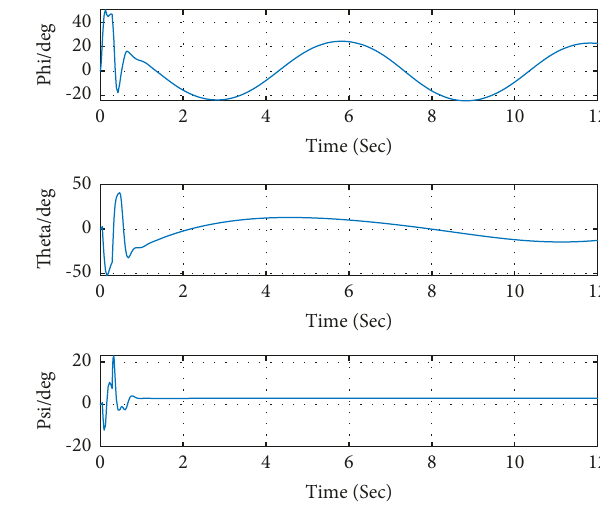
Figure 12: The curve of attitude angle.